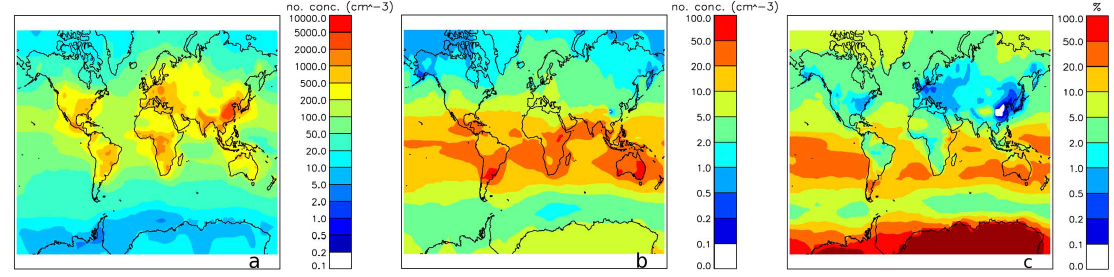
Fig. 6. (a) The annual average CCN > 35nm dry radius number concentration at the surface, calculated from the Kettle and Andreae (2000) climatology (CLIM1). (b) The difference in CCN between a simulation with no DMS and CLIM1, i.e. the absolute contribution of DMS to CCN. (c) The fractional contribution of DMS to